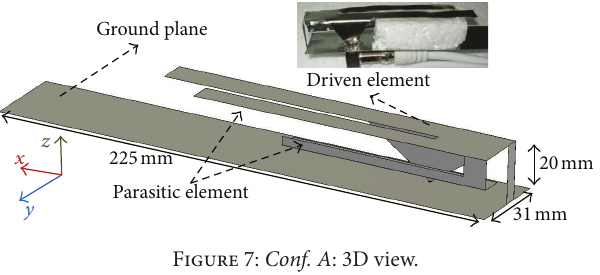
Figure 7: Conf. A : 3D view.